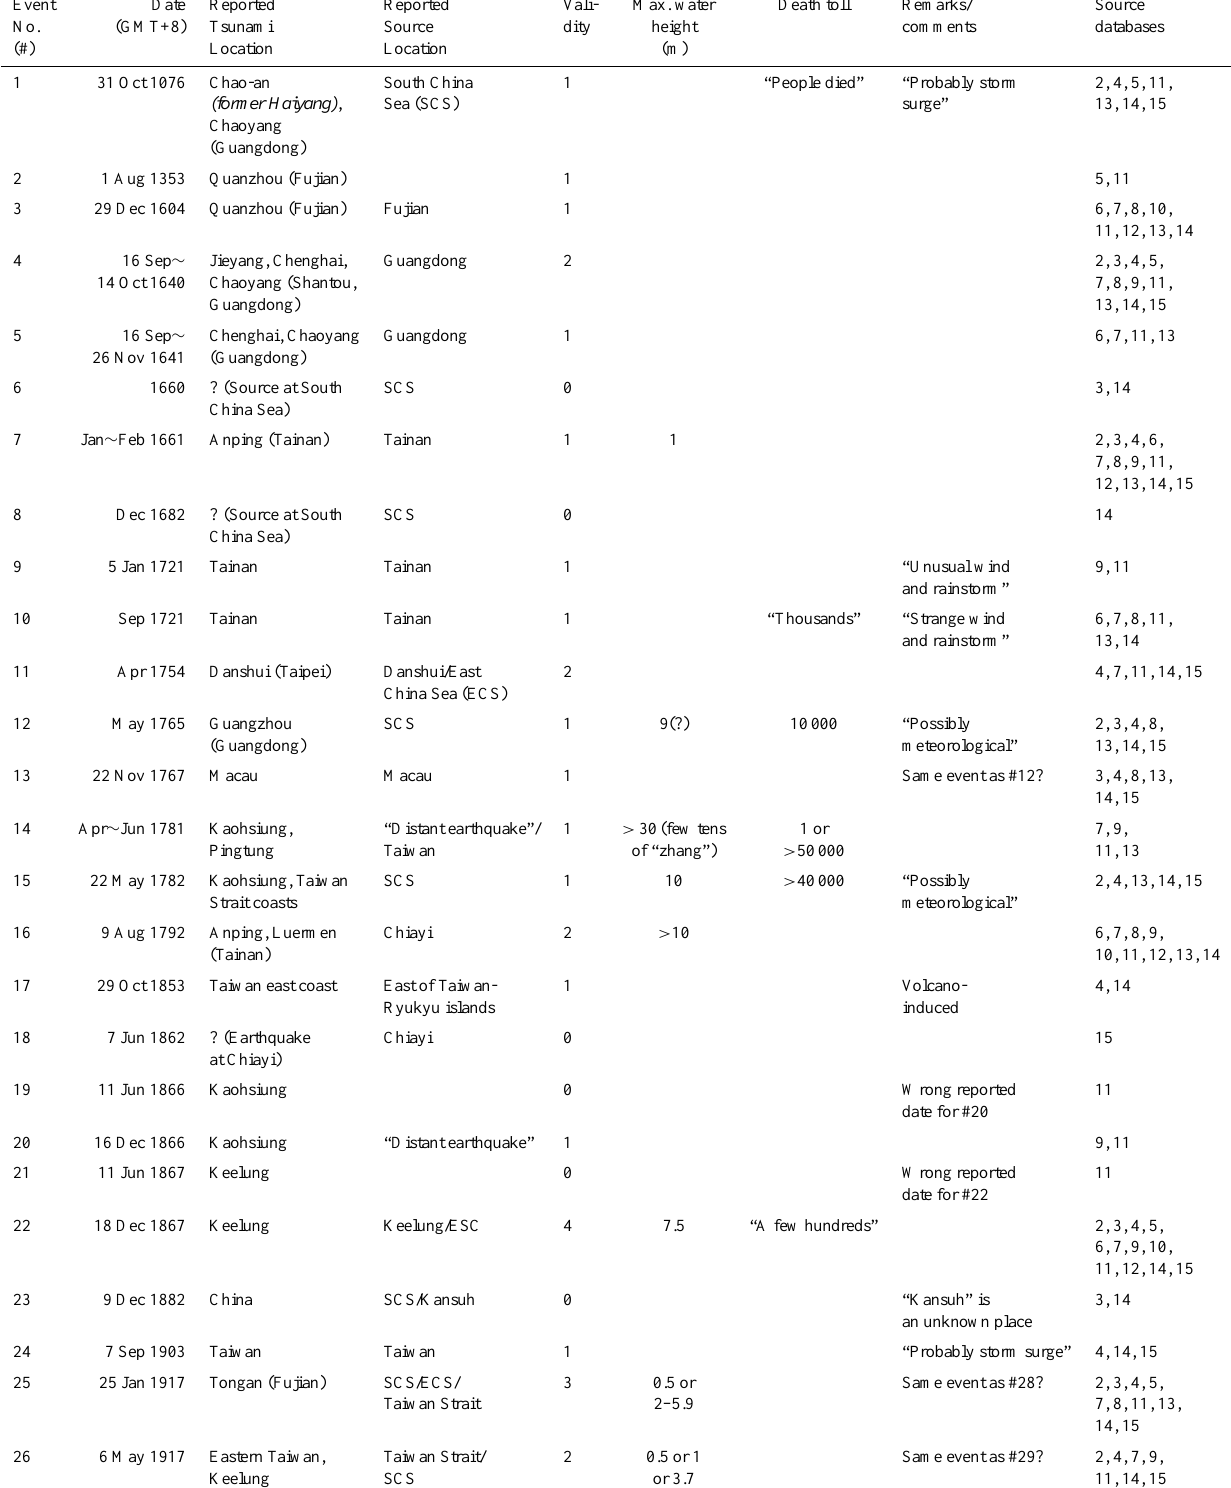
Table 3. A database of historical tsunamis in the NE South China Sea region with validity score assigned. Validity score – 0: Invalid, 1: Doubtful, 2: Possible, 3: Probable, 4: Valid. Source database – 1: Cheng (1965), 2: Iida et al. (1967), 3: Berninghausen (1969), 4: Soloviev and Go (1974), 5: Li (1981), 6: Zhou and Adams (1986), 7: Yang (1987), 8: Lee (1988), 9: Y¨u (1994), 10: Wang et al. (2005), 11: Li